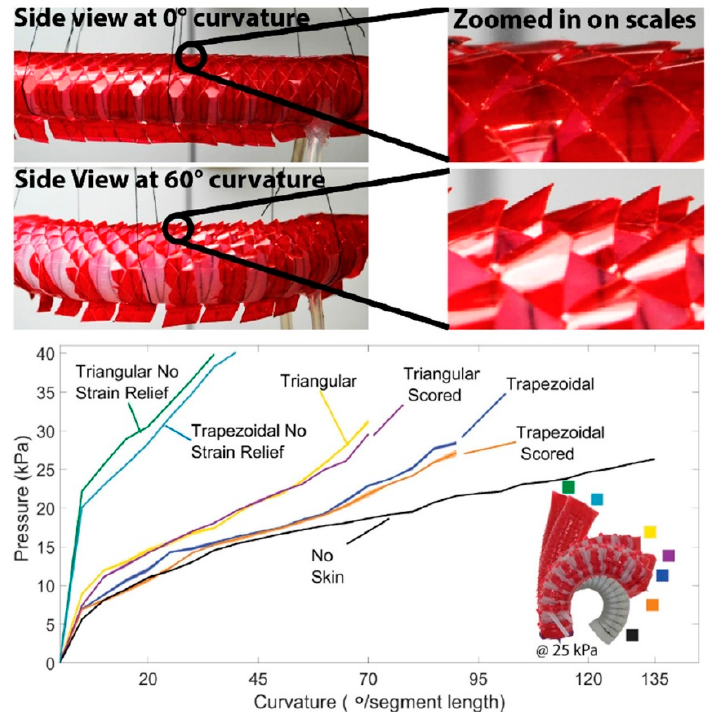
Figure 20. Photographs above: Snake-inspired Kirigami skin for lateral undulation of a soft snake robot with and without curvature. Effect of strain relief designs on curvature vs. pressure relationship. Inset shows the achievable curvature of each skin when the actuator is inflated to the same pressure. Reprinted/adapted with permission from Ref. [219]. Copyright 2020, IEEE.